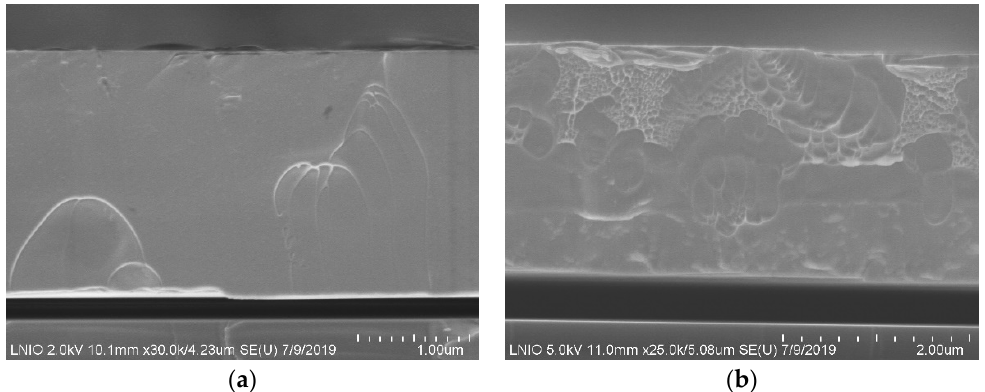
Figure 1. The cross-sectional SEM images of deposited thin film metallic glasses (TFMGs): ( a ) 0 at % of Ta; ( b ) 30 at % of Ta.